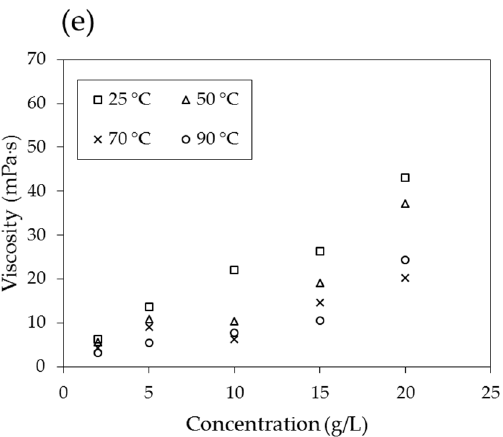
Figure 8. Viscosity with respect to concentration of the solution at shear rates of ( a ) 3.4 s − 1 ; ( b ) 6.8 s − 1 ; ( c ) 17 s ´ 1 ; ( d ) 34 s ´ 1 ; and ( e ) 68 s ´ 1 .